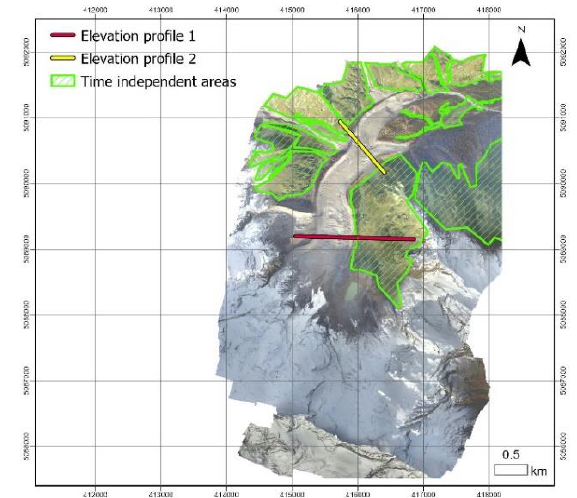
Figure 10 – Time independent areas for the vertical DSM accuracy assessment and elevation profile transects